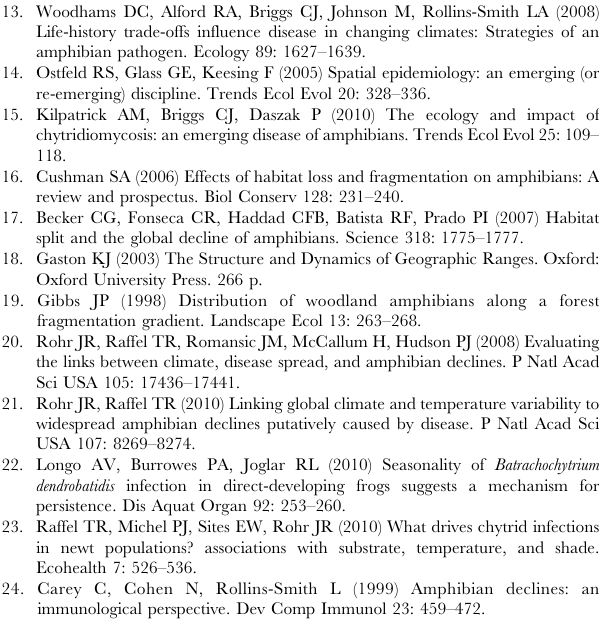
Table S1 Model selection for environmental and bio- logical variables influencing Batrachochytrium dendro- batidis ( Bd ) prevalence and infection intensity in populations of Lithobates clamitans in the Adirondack region, New York,